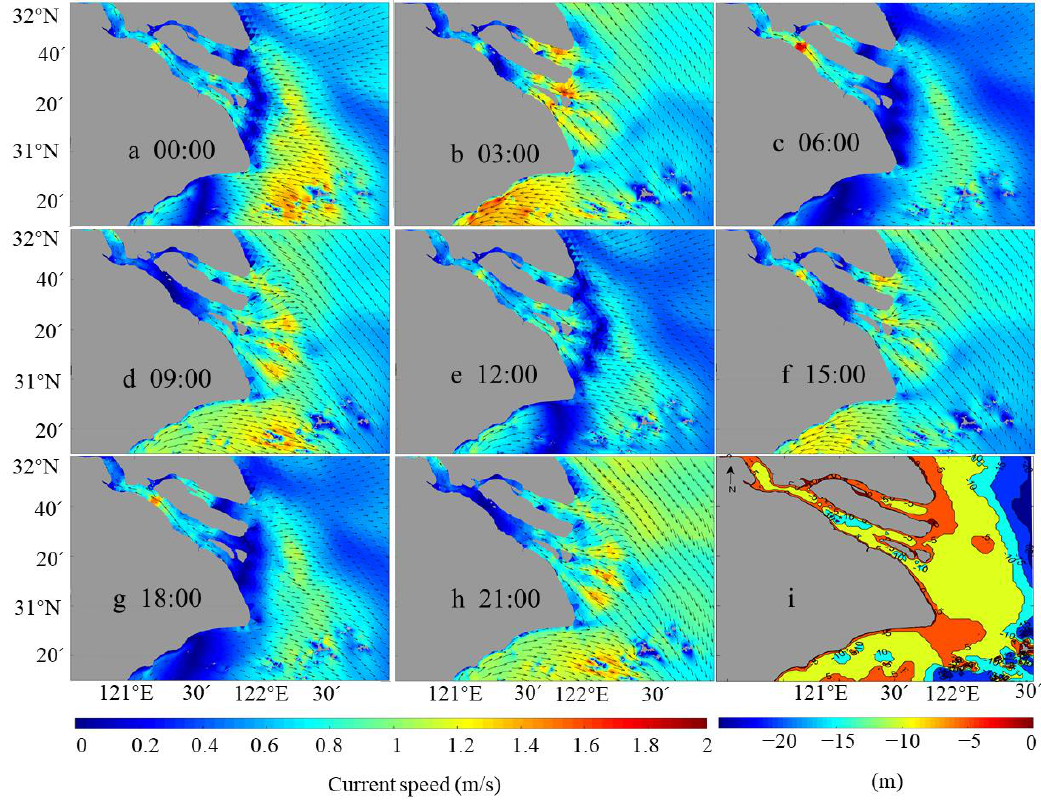
Figure 10. ( a – h ): Tidal current obtained every 3 h from 0:00 on 30 November 2020. ( i ): The bathymetric topographic map. Black arrow: tidal current direction.